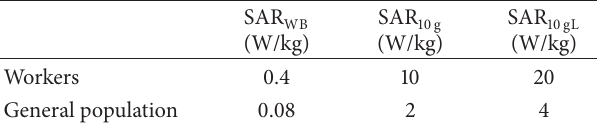
Table 1: ICNIRP basic restrictions in the 100 kHz–10 GHz band